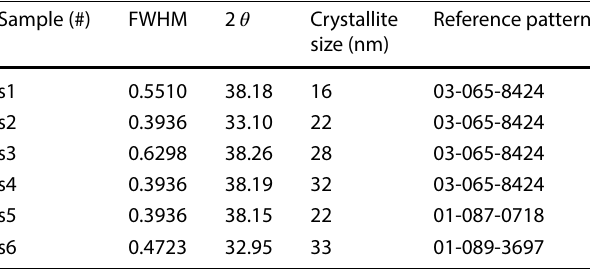
Table 3 Summary of XRD data for monometallic gold and silver NPs and bimetallic structures Sample (#)